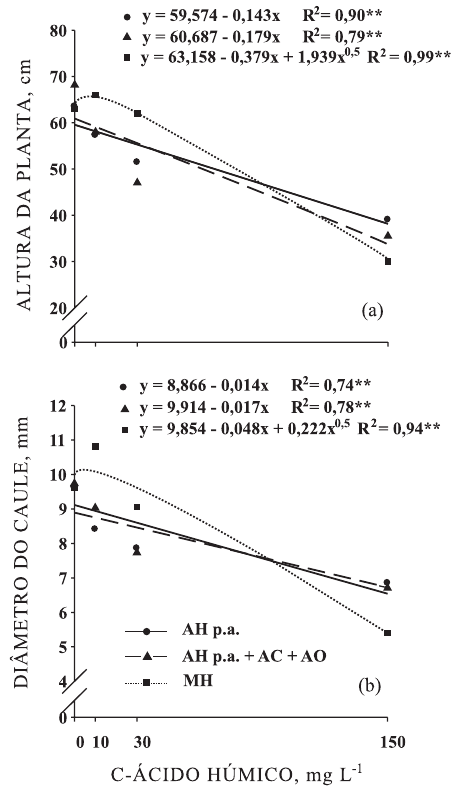
Figura 1. Altura da planta (a) e diâmetro do caule (b) de mudas de eucalipto em resposta ao aumento de concentrações de C-ácido húmico em solução nutritiva. AH p.a.: ácido húmico p.a.; MH: material húmico; AC: ácido cítrico; AO: ácido